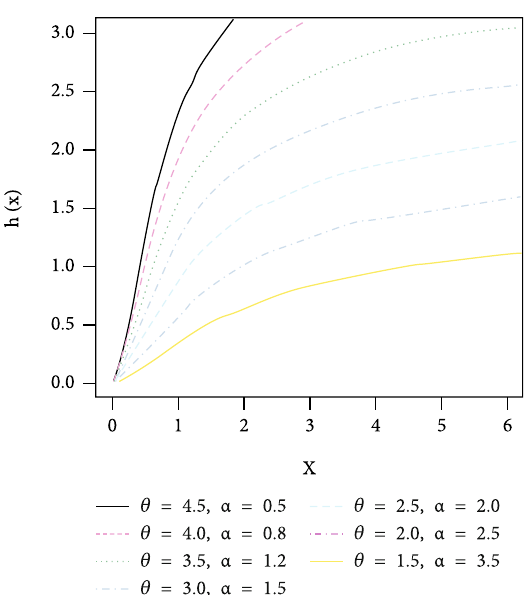
Figure 4: The cdf of DWQL model.